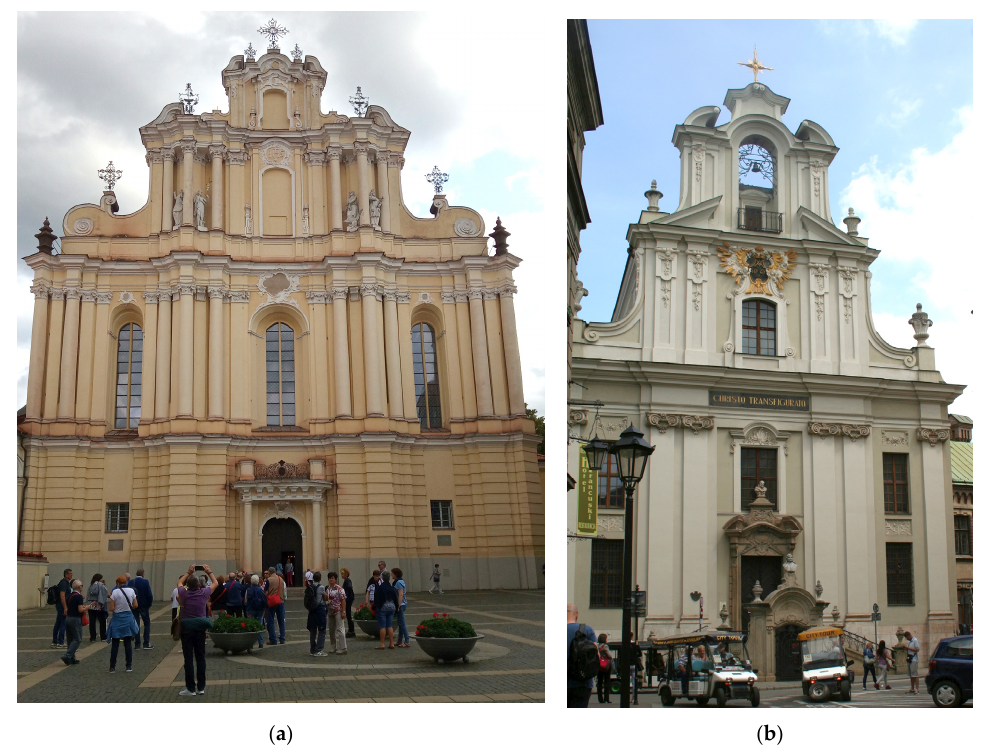
Figure 17. The late Baroque examples of highlighting the vertical articulation of the architectural structure with color: ( a ) the façade of the church of St. John the Baptist and St. John the Evangelist in Vilnius (1738–1749); ( b ) the façade of the Piarist Church in Cracow (1759–1761). Photos by author.